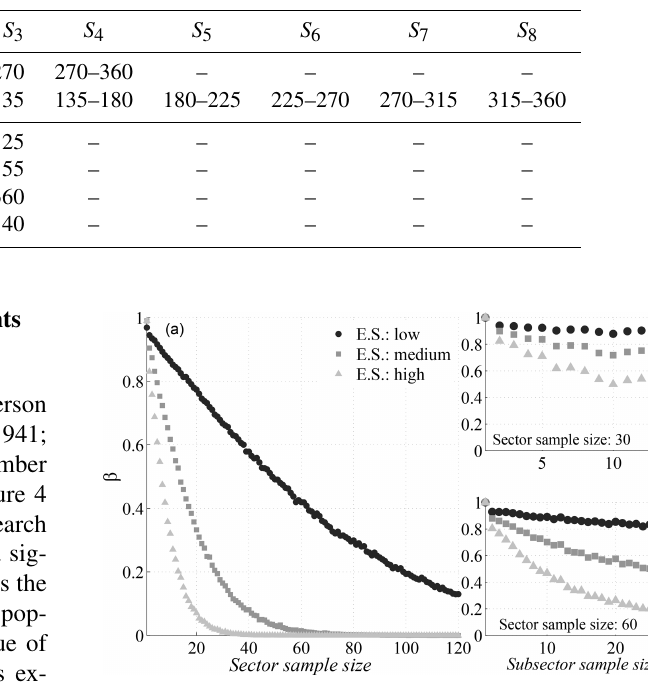
Figure 4. (a) Power curves of the AD test. (b) Power curves of the KS test for a total sector sample size of 30. (c) Power curves of the KS test for a total sector sample size of